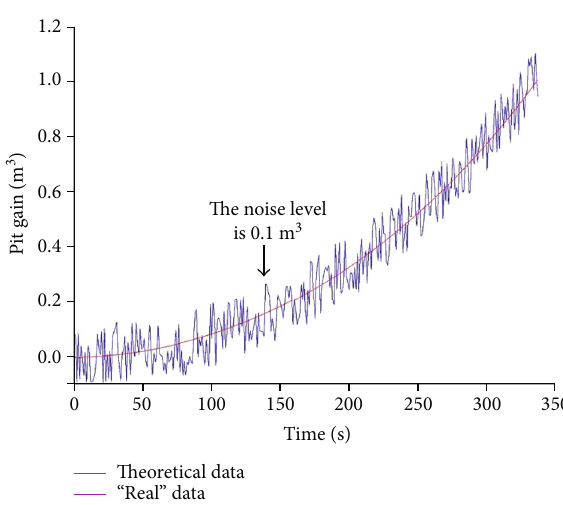
Figure 4: A sample of theoretical data and “ real ” data of pit gain (noise level: 0.1m 3 ).